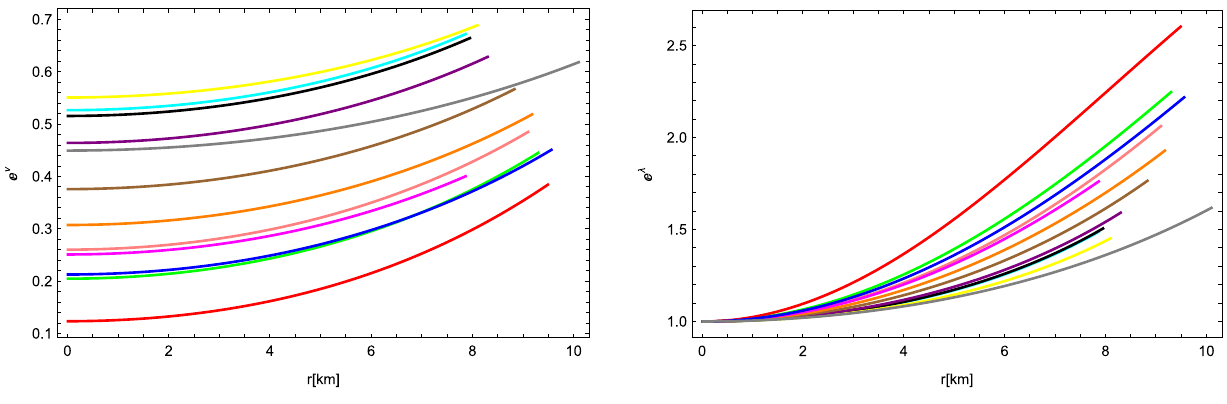
Fig. 1 Graphical Behavior of g tt and g rr of S 1 ( (cid:2) ), S 2 ( (cid:2) ), S 3 ( (cid:2) ), S 4 ( (cid:2) ), S 5 ( (cid:2) ), S 6 ( (cid:2) ), S 7 ( (cid:2) ), S 8 ( (cid:2) ), S 9 ( (cid:2) ), S 10 ( (cid:2) ), S 11 ( (cid:2) ), S 12 ( (cid:2) )